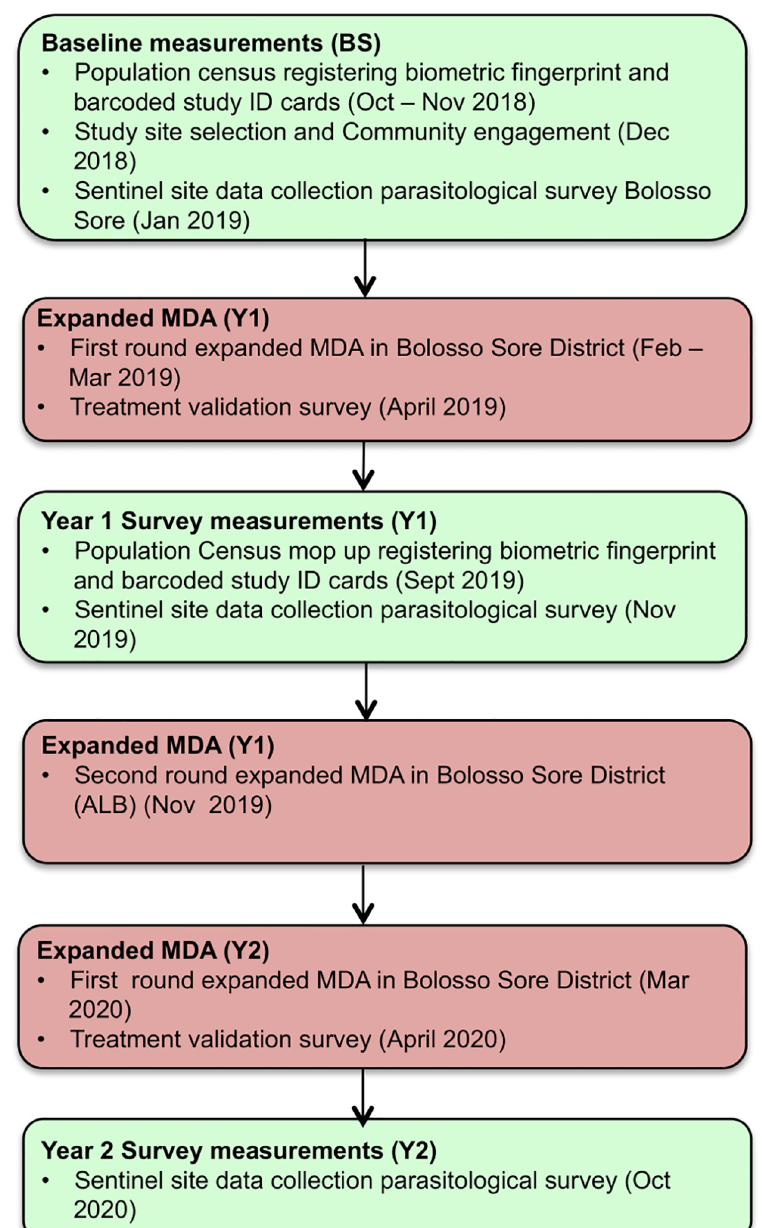
Fig 1. Timetable of MDA and parasitological survey across Bolosso Sore woreda. Flow chart of time line describing the biometric registration and community engagement (BS), Expanded MDA round one and two with following parasitological survey (Y1) and midpoint parasitological survey